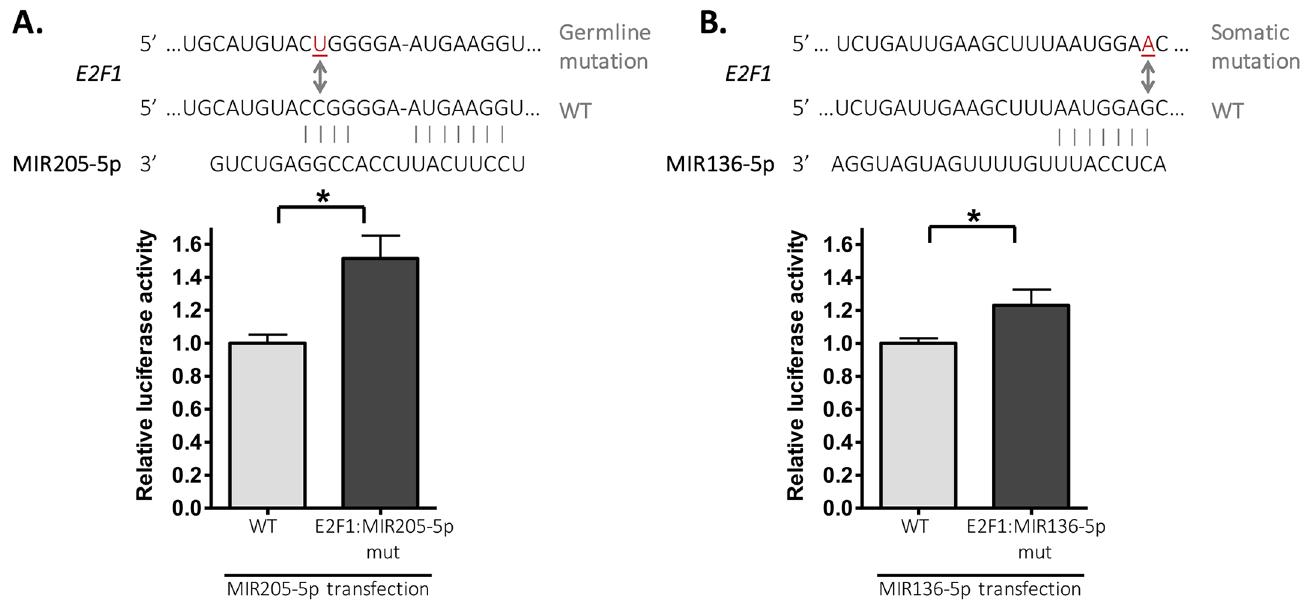
Fig 3. Reporter assaysdemonstrate that constructs containing E2F1 mutations enhance gene activity relative to the wild-type (WT) construct. Scheme shows pairingbetweenmiRNA and E2F1 WT or mutated sequence,as predicted by TargetScan. HCT116cells were manipulated to stably express luciferase reporter constructs that containthe partial sequenceof E2F1 3’UTR WT, mutated at the MIR205-5ptarget site (A) or at the MIR136-5ptarget site (B). Cells were transiently transfected with control miRNA or miRNA mimics (MIR205-5p (A) or MIR136-5p (B)); luciferase activity was assayed after 48h. Values show luciferaseactivity relative to WT after normalizing to the respectivemiRNA control-transfected cells, and indicate the averageof three independentexperiments ± standarddeviation(SD). * P (cid:20) 0.02, unpairedt-test.